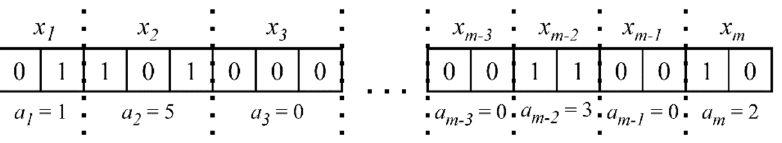
Figure 2. The binary representation of a rule. Parts of a binary string consecutively code the predictors’ levels or their absence in the rule.